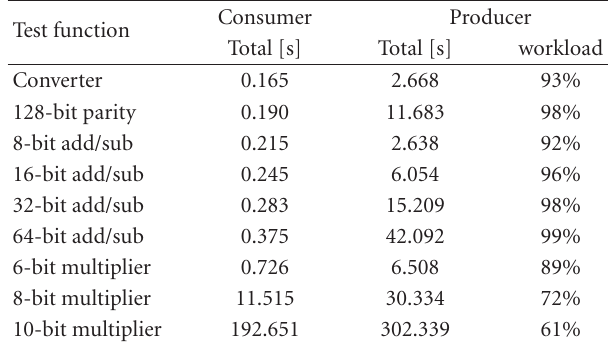
Table 3: Runtimes comparison between consumer and producer. Test